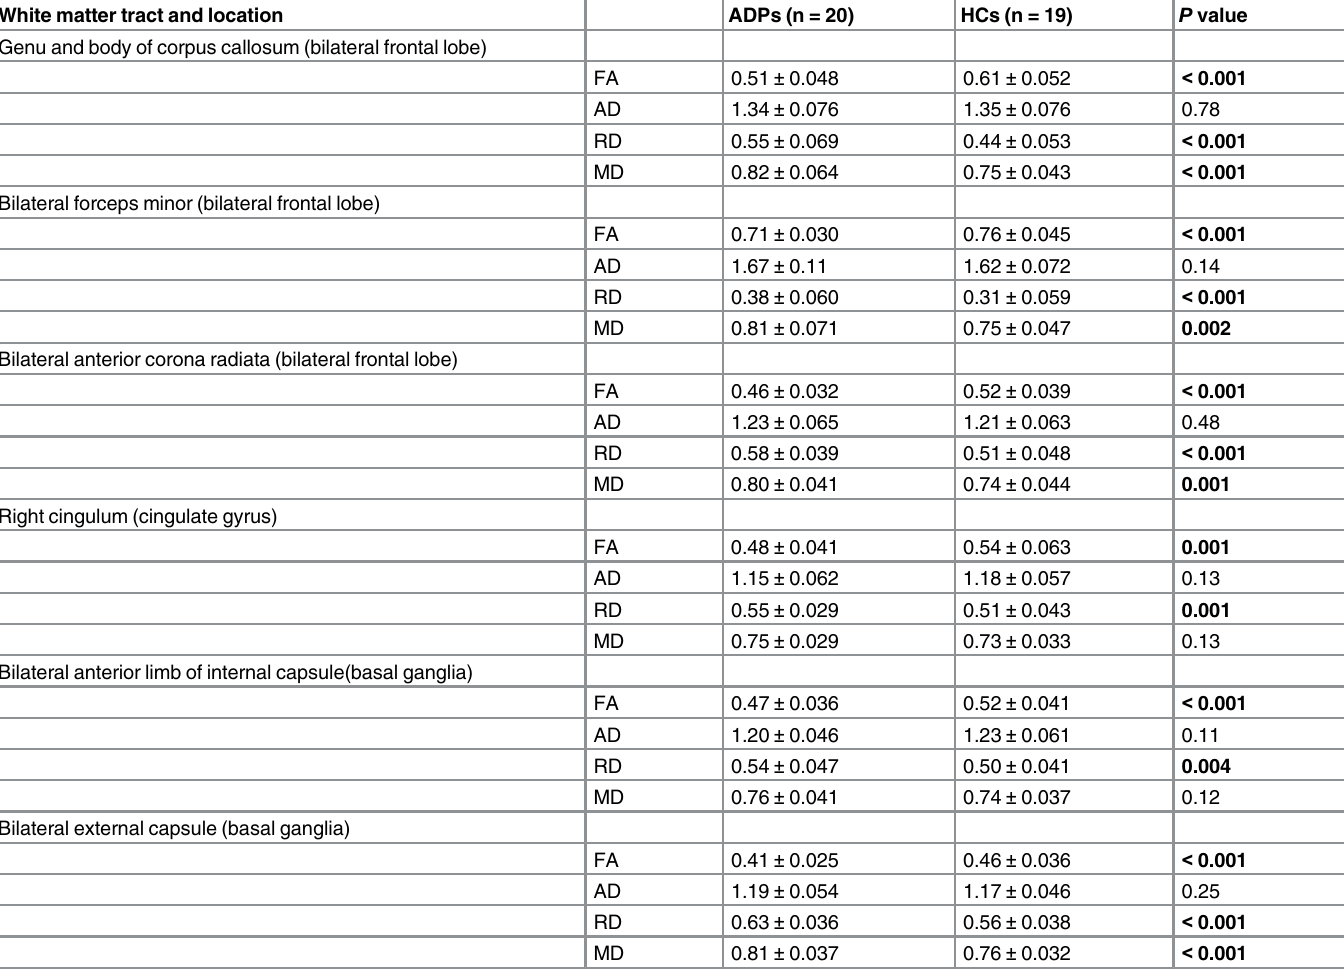
Table 4. Mean ( ± SD) values of DTI parameters in the cluster in which decreased FA was observed in TBSS analysis in ADPs versus HCs ( p < 0.01, TFCE corrected). White matter tract and